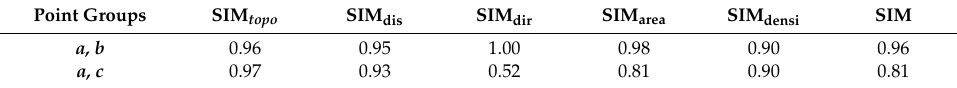
Table 3. Calculation results of similarity among the three point groups.